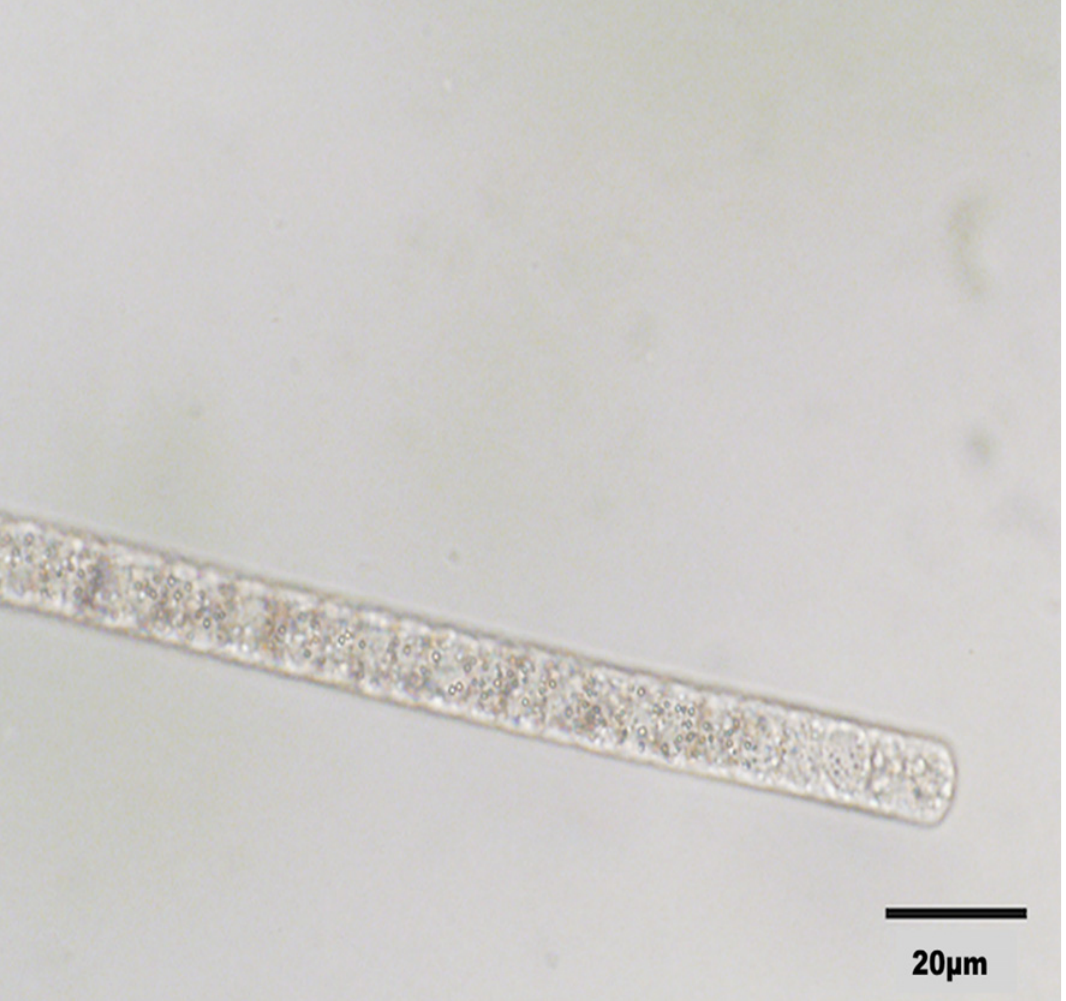
Fig 5. Brightfield image of Beggiatoa sp. filaments removed from disease lesions. Image taken at 60x magnification. Black bar represents 20 μ